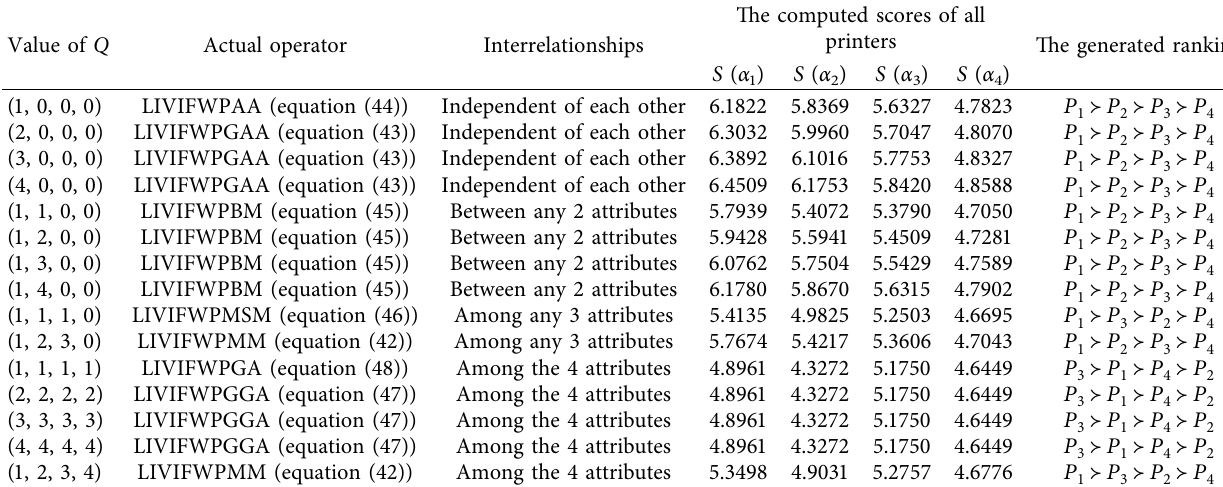
Table 3: The details and results of the exploration